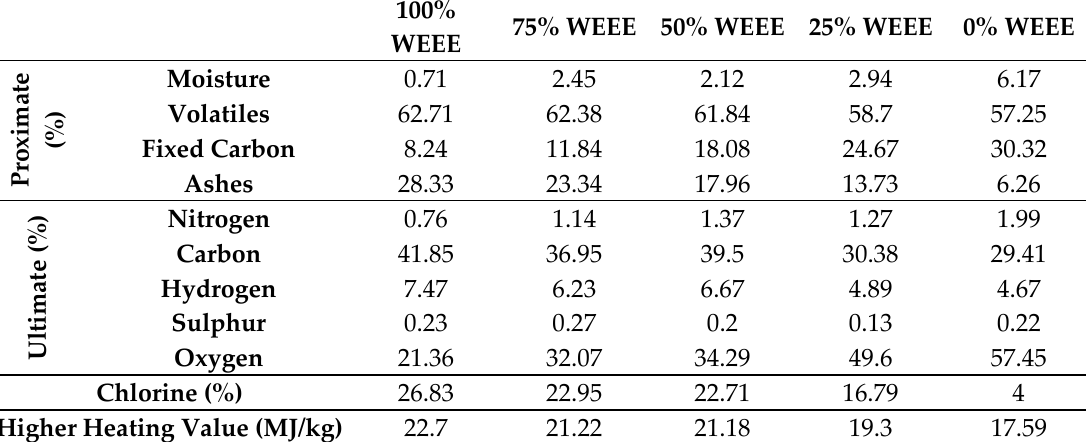
Table 1. Analysis of the different raw mixtures.